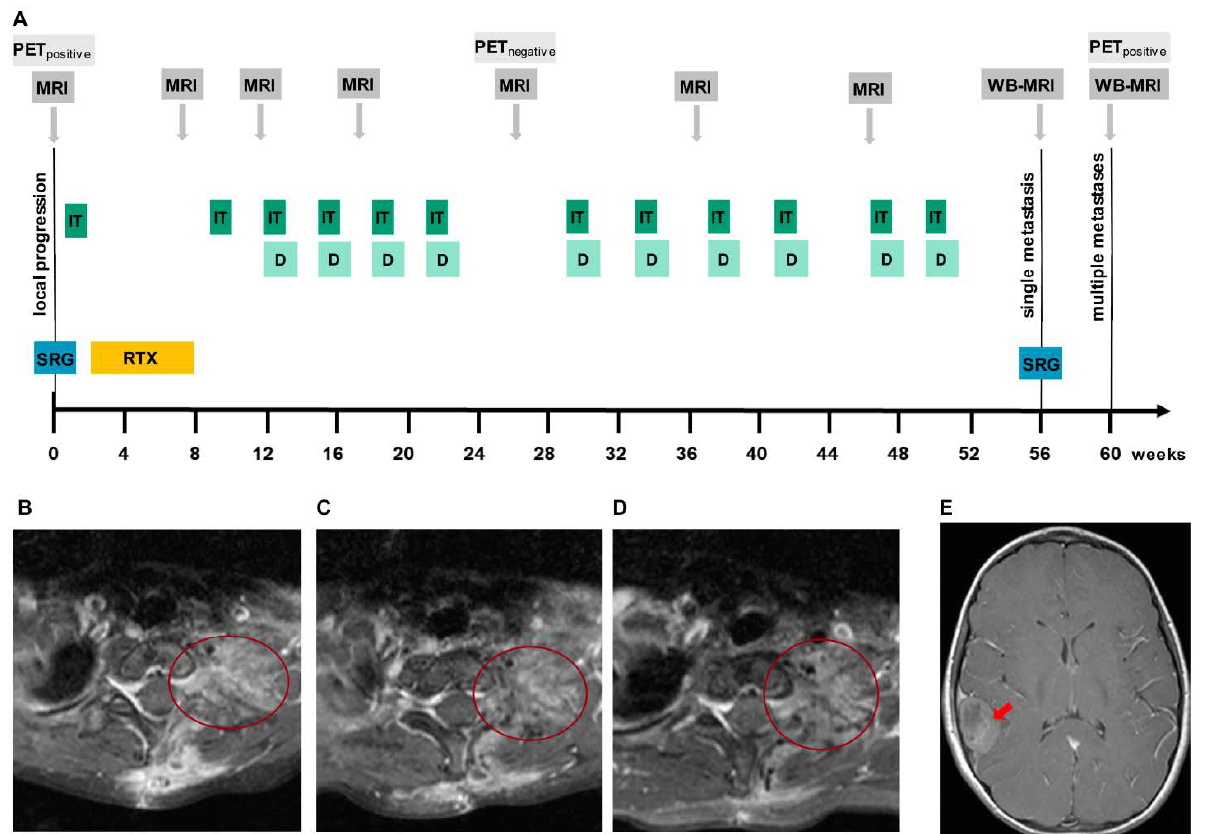
Figure 6. Clinical efficacy of dinutuximab in an ES patient. ( A ). Therapy protocol used for off-label application of dinutuximab beta. SRG: surgery; IT: irinotecan/temozolomide; RTX: irradiation of the primary tumor site. ( B – D ) Transversal T1-weighted fat-saturated turbo spin echo MRI sequences demonstrating post-therapeutic contrast enhancement at the upper left thoracic aperture lateral to the C7/Th1 neural foramen at week 7 ( B ), which was regressive at week 10 ( C ), with no signs of local progression at week 47 ( D , E ). Transversal T1-weighted contrast-enhanced spin echo MRI sequence showing a right temporal skull metastasis growing invasively into the brain at week 56 (red